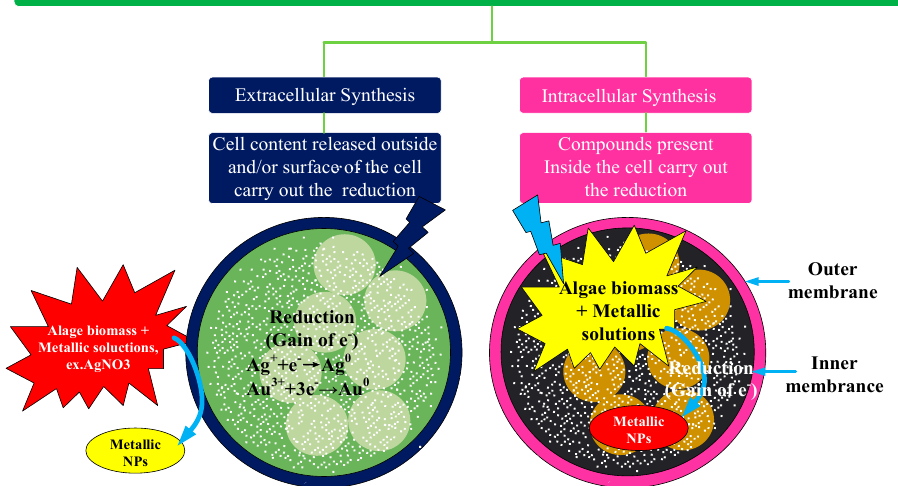
Figure 9. Mechanism of intracellular and extracellular microbes mediated synthesis of NP. Reprinted/adapted with permission from Ref. [55]. Copyright 2016, Elsevier.